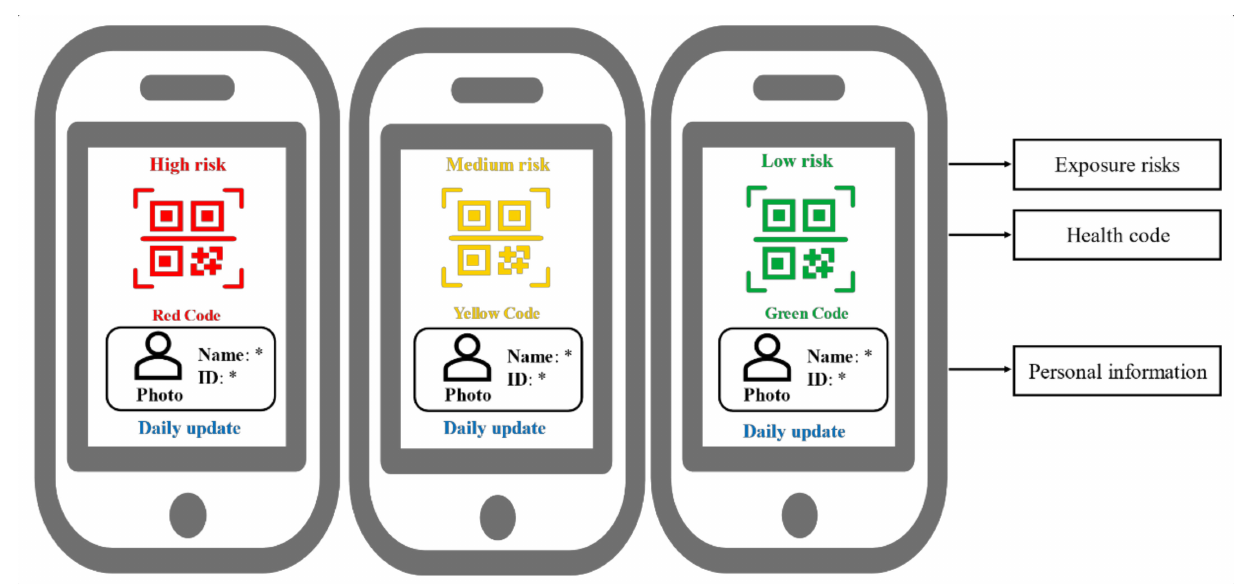
Figure 1. A red-yellow-green system of health codes [4]. The quick response (QR) codes maintain